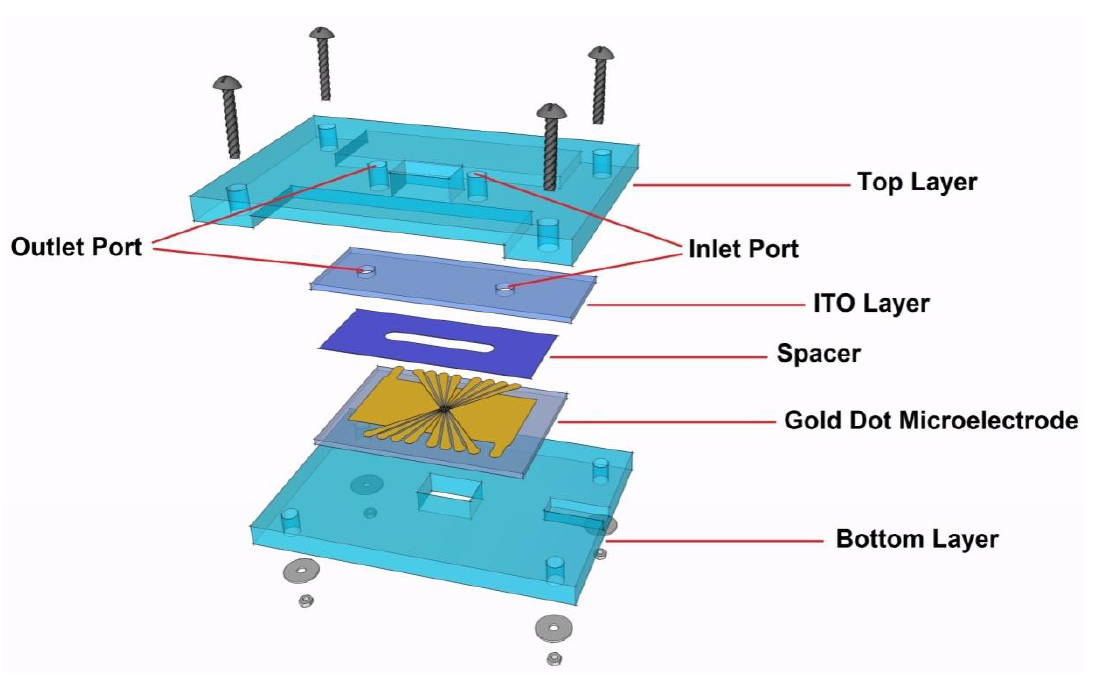
Figure 6. A schematic diagram of the proposed LOC device.